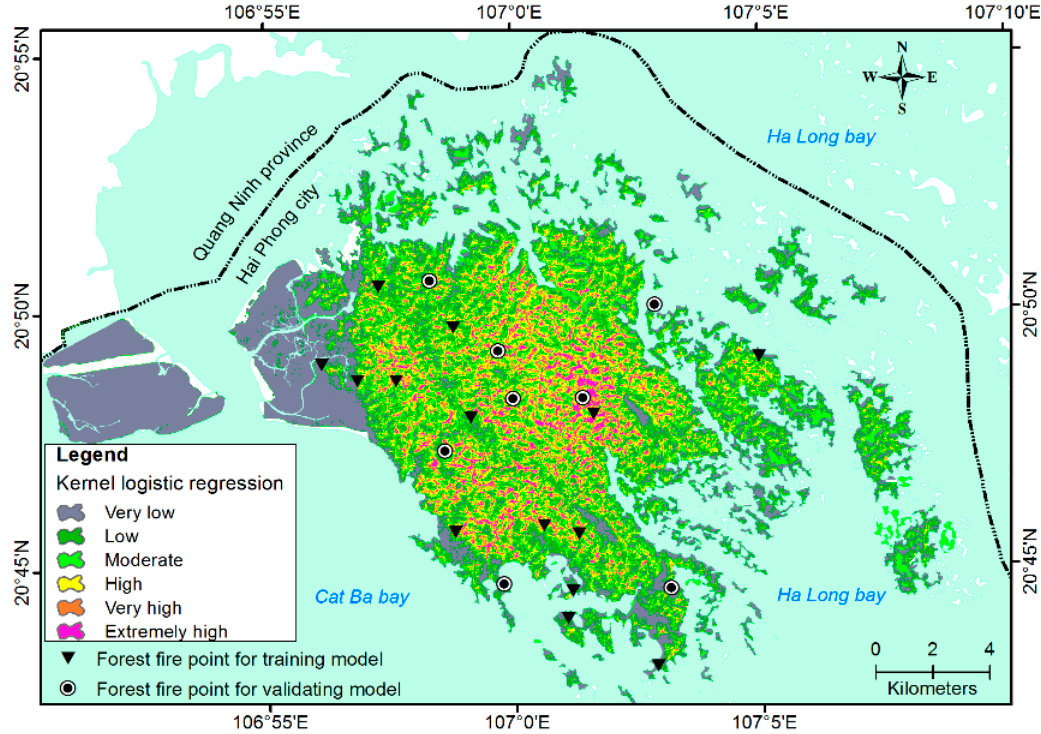
Figure 4. Forest fire susceptibility map for Cat Ba National Park area, Hai Phong City (Vietnam) using the Kernel logistic regression model.